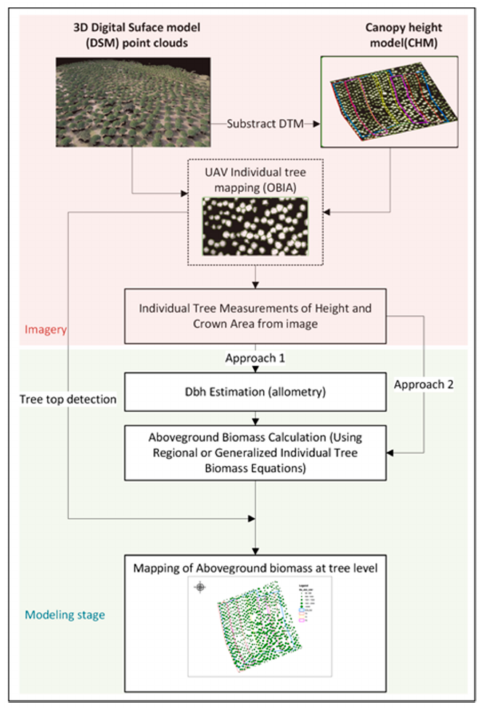
Figure 4. Summary steps of ITC to map aboveground